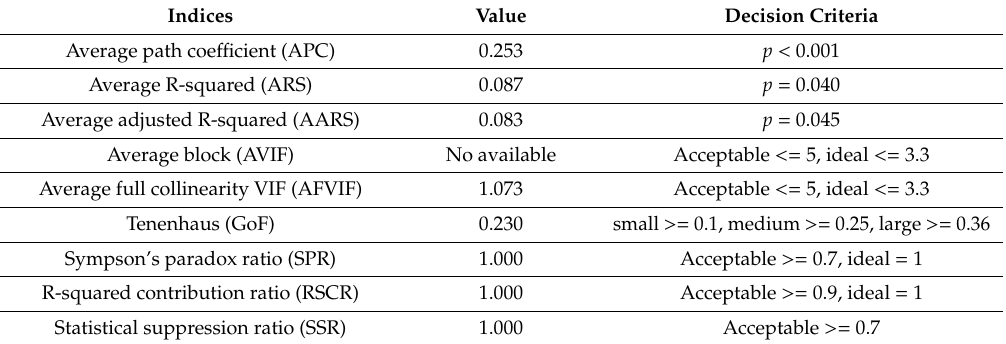
Table 5. Model 2. E ffi ciency indices of the relationships between physical activity dimensions and